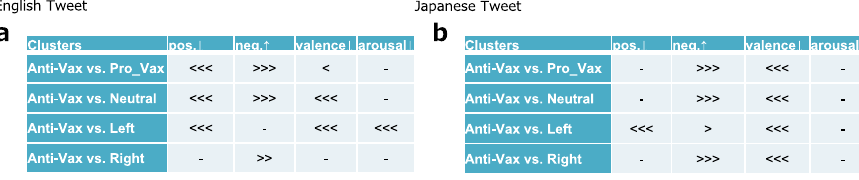
Fig. 5 Comparison of emotions of inter-cluster replies. a for English and b for Japanese. The comparison is based on each feature using the Mann – Whitney U -test with a Bonferroni correction. The direction of the brackets indicates the cluster with the larger amount. ‘ < < < ’ : p < 0.001, ‘ < < ’ : p < 0.01, ‘ < ’ : p <